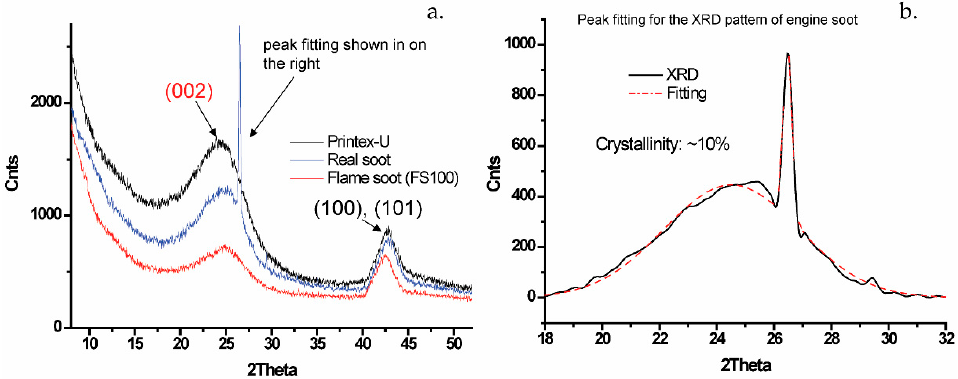
Figure 3. ( a ) XRD patterns for Printex-U carbon black, Engine soot, and flame soot FS100; ( b ) The fitted curve for the XRD pattern of engine soot.